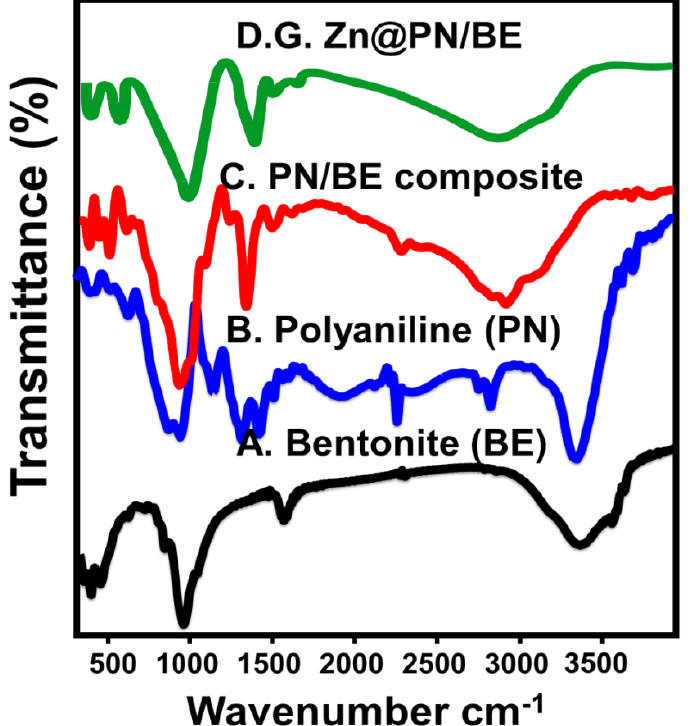
Figure 3. FT–IR spectra of raw bentonite (BE) ( A ), polyaniline ( B ), polyaniline/bentonite composite (PN/BE) ( C ), and the synthetic G.Zn@PN/BE green composite ( D ).